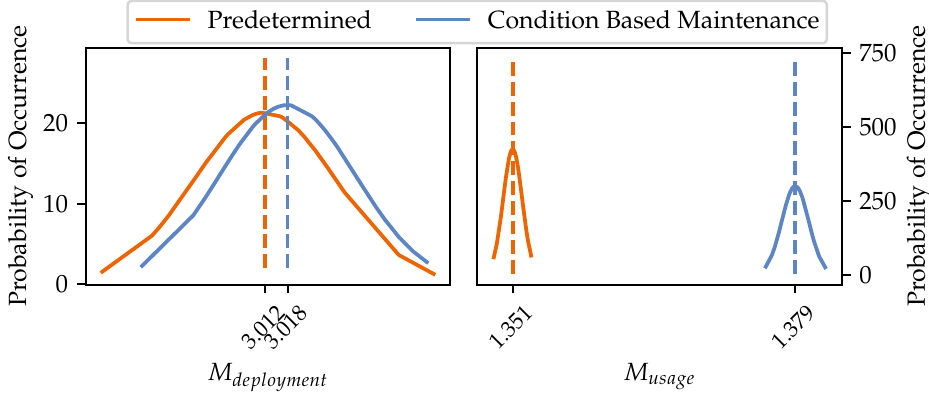
Figure 9. Normal distribution of evaluation results for ten predetermined maintenance experiments and ten condition-based maintenance